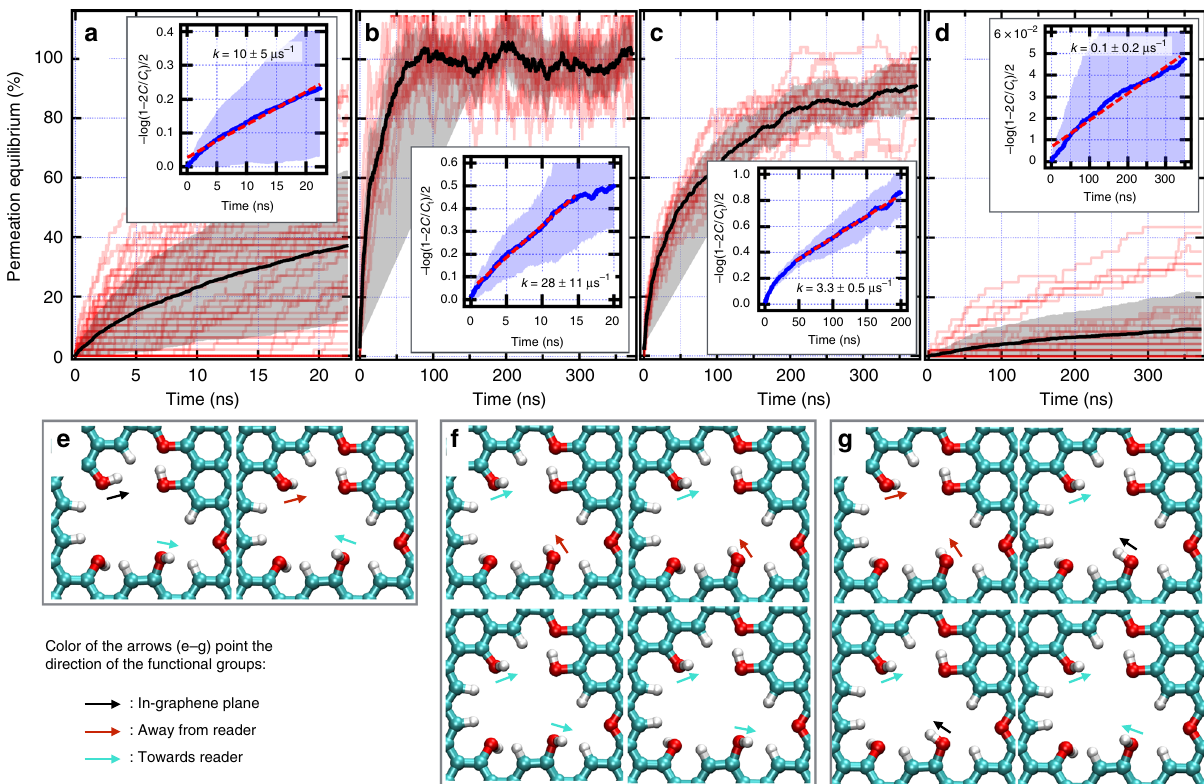
Fig. 4 Effect of nanowindow dihedral rotation on N 2 permeation rates. a – d Molecular dynamics results of N 2 permeability at 77 K. Thin red lines are single runs, the thick black line is the average of all runs in red and the shaded area is standard deviation. The inset is the linearization of all data including a linear fi t to the average. k is the permeation rate constant where uncertainty is 1 SD. Results are divided in a all results for a fl exible nanowindow framework and for a rigid framework grouped in b fast, c medium, and d slow. e – g Show several representative orientations of functional groups for b , c , and d regimes, respectively. Colored arrows indicate the orientation of O(1 – 2) – H bond. Cyan, red, and white atoms are C, O, and H, respectively. All these results correspond to